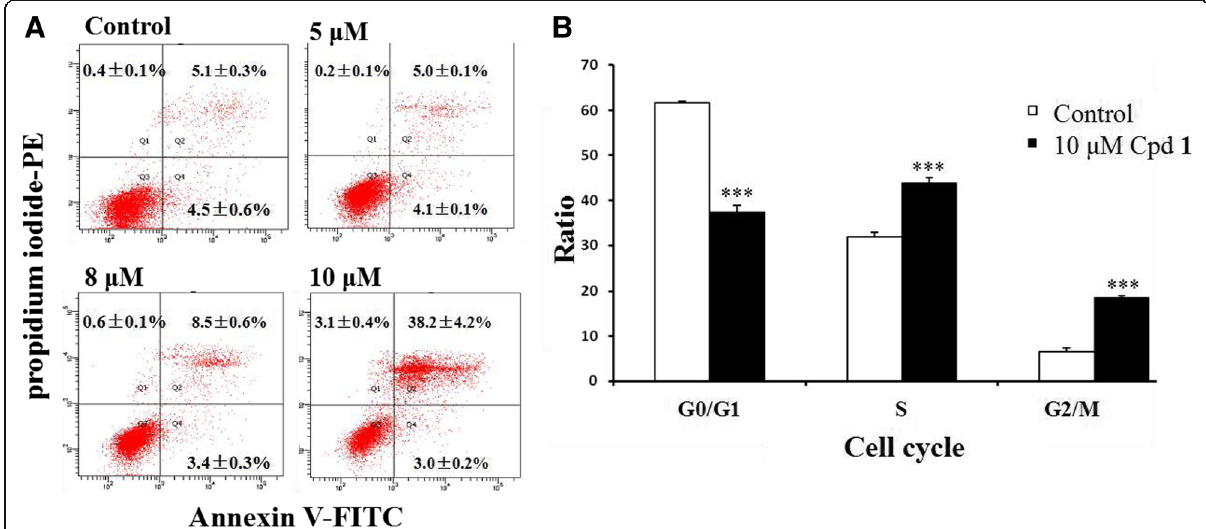
Fig. 5 The analysis of cell apoptosis and cell cycle distribution of HCC CSCs induced by 2-ethoxystypandrone (1). a . 2-Ethoxystypandrone (1) induced cell apoptosis of HCC CSCs in dose-dependent manner. Apoptosis rates of HCC CSCs after being treated with 2-ethoxystypandrone (1) at the indicated concentration for 24 h. b . The cell cycle distribution of HCC CSCs after being treated with 2-ethoxystypandrone (1) at the concentration of 10 μ M for 24 h. Values are means+SEM, * p < 0.05 and *** p < 0.001, compared to control group. Two-tailed unpaired T-Test was used for statistical analysis by SPSS 19.0